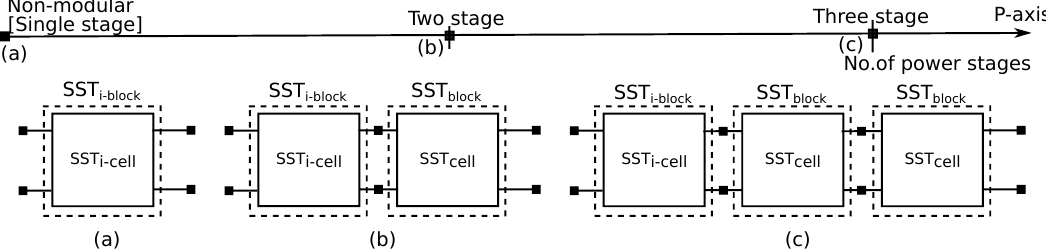
Figure 16. Modularization in the direction of power flow: ( a ) non-modular or single stage SSTs, ( b ) two-stage SSTs, and ( c ) three stage SSTs.